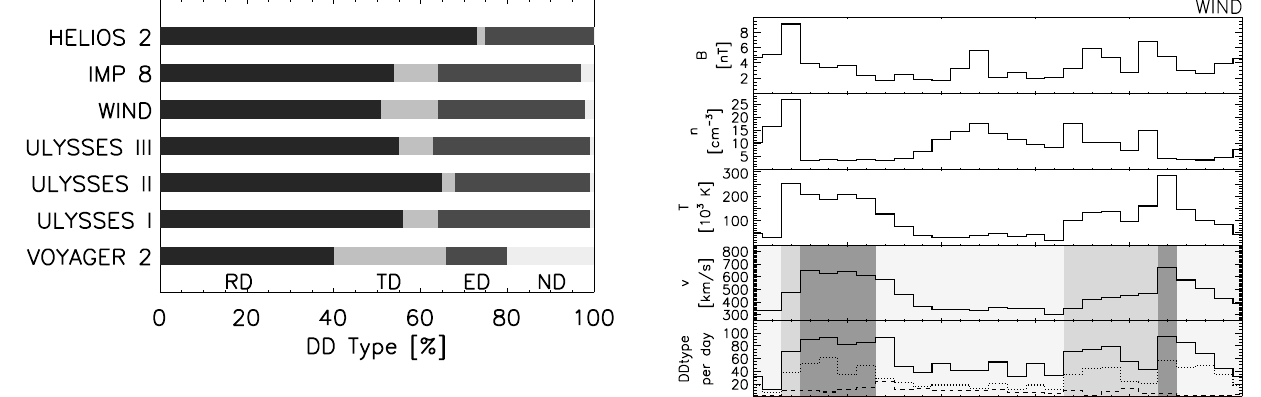
Fig. 9. Distribution of the DD types for the 7 intervals